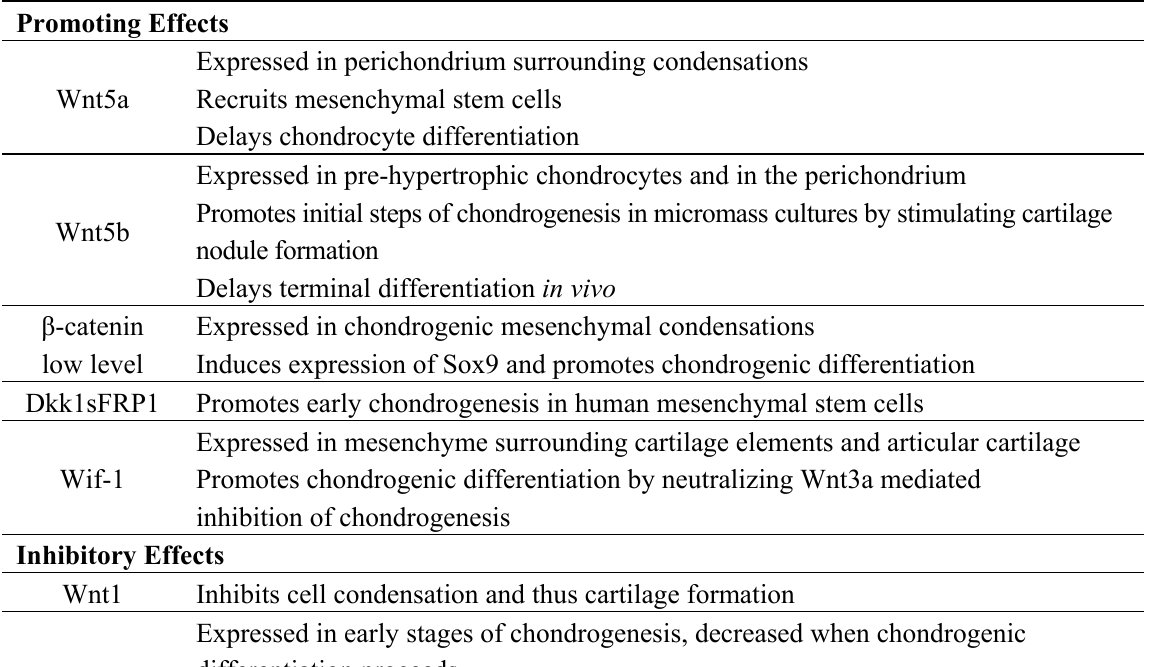
Table 1. Role of Wnt signaling during early stages of cartilage